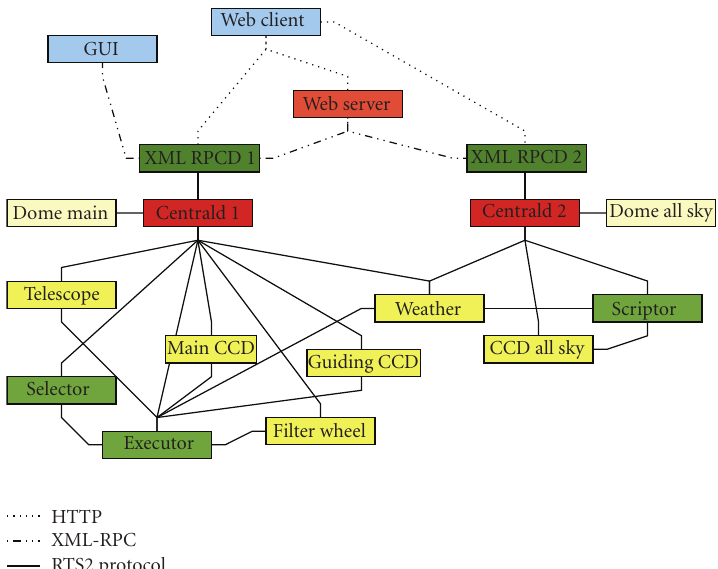
Figure 1: Example RTS2 environment. Two basic setups are present on the site—a telescope with a guiding CCD and a main CCD equipped with a filter wheel, and an all sky camera. There are two domes (one for telescope, second for all sky camera), three CCD detectors, executor and selector services controlling telescope setup and scriptor , a simplified executor service, controlling the all sky camera. Both observatories o ff ers external access through XML-RPC protocol, provided by XMLRPCD . This is used by the Graphical User Interface and the Web server. XMLRPCD also provides a Web browser with direct access to some functions. Access to XML-RPC and Web functions can be protected with a